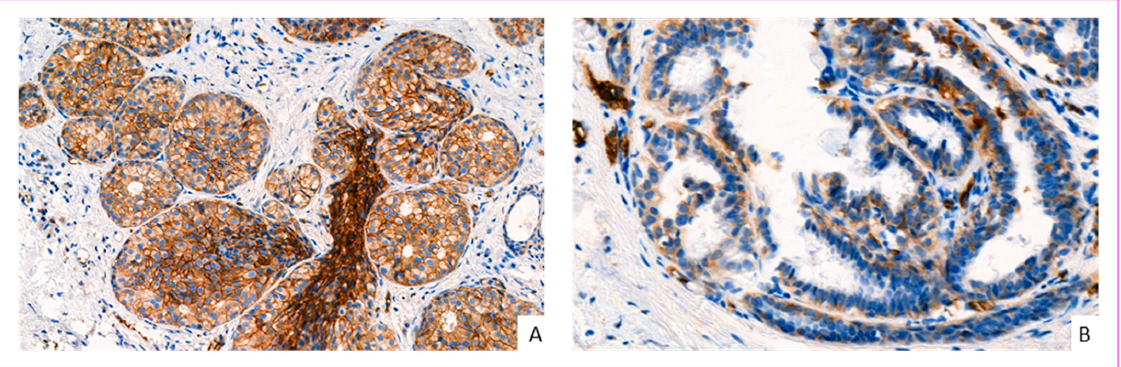
Figure 4. GLUT-1 IHC staining in ductal carcinoma in situ. ( A ) GLUT-1 overexpressed (score 3) in ductal carcinoma in situ of intermediate nuclear grade (magnification ×400). ( B ) Atypical hyperplasia: epithelial cells show weakly membrane staining in <10% of ductal cells (score 1) (magnifica- tion ×600). Table 9. Comparison of GLUT-1 overexpression between non-obese diabetic patients and the gen- eral population .